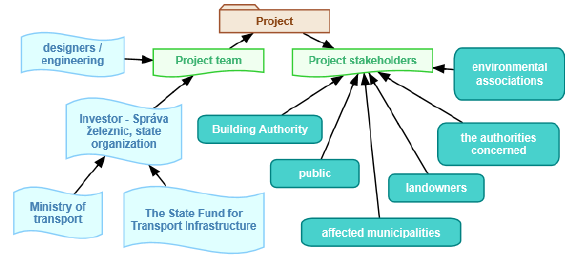
Figure 3. The relation between stakeholders and the project, source: